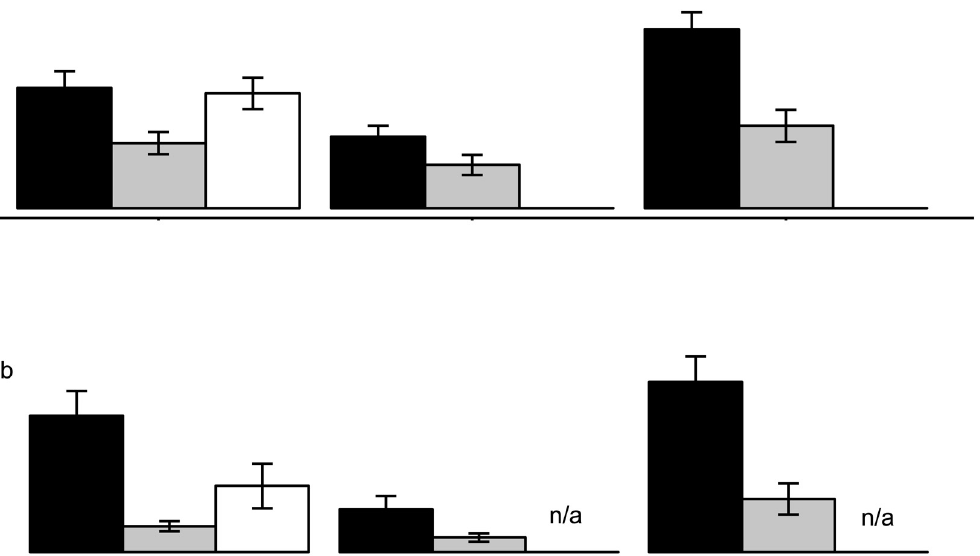
Fig 5. Parasite richness and abundance for lionfish and native hosts in three sites in Panama. Parasite richness (mean number of parasite taxa per host ± SE) is shown in (A), while parasite abundance (mean number of individual parasites per host ± SE) is shown in (B). Each host species is represented by a specific color: Cephalopholis cruentata (black bars), P . volitans (grey bars), and Synodus intermedius (white bars). Sample sizes for each species varied among sites: Cristobal ( C . cruentata , n = 19; P . volitans , n = 19; S . intermedius , n = 14), Hospital Point ( C . cruentata , n = 20; P . volitans , n = 17), and Portobelo ( C . cruentata , n = 19; P . volitans , n = 21). Note that S . intermedius was collected only in Cristobal and was absent in the other sites.